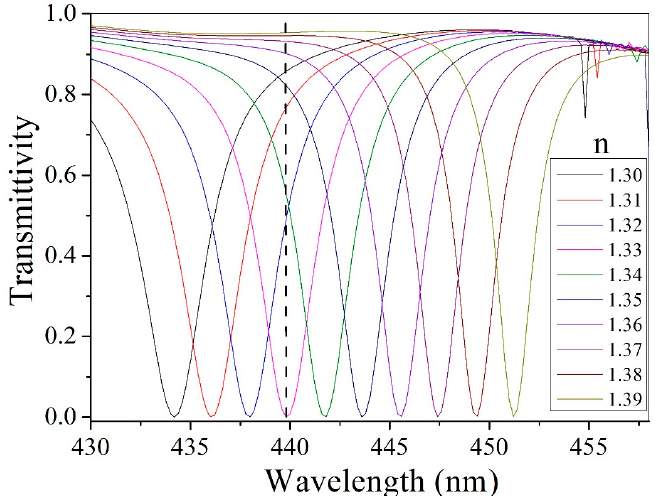
Figure 5. Simulated transmission spectrum of metasurfaces placed in environments with a refractive index ranging from 1.3 to 1.39. The black vertical dashed line is marked to calculate FOM* .